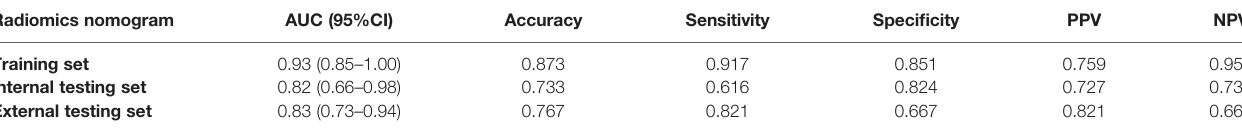
TABLE 3 | Predictive performance of the radiomics nomogram.